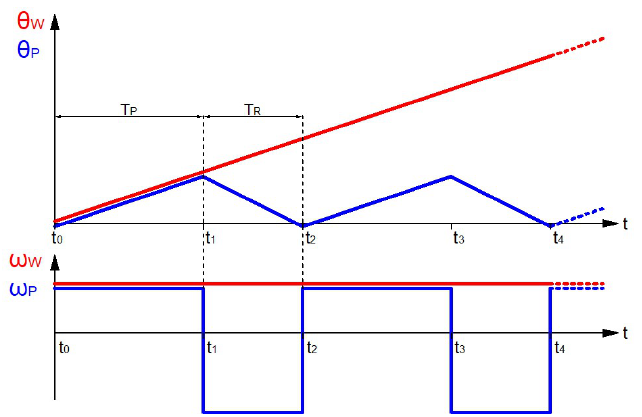
Figure 3. Angular speed and angular position of the pulley and the wheel.